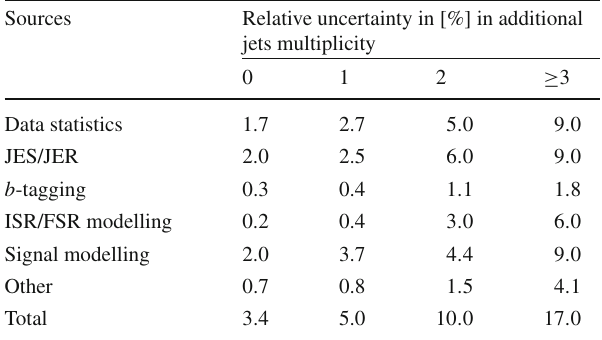
Table3 Summaryofrelativeuncertaintiesin[%]forthejetmultiplicity measurement using a jet p T threshold of 40 GeV. “Signal modelling” sources of systematic uncertainty includes the hadronisation, parton showerandNLOmodellinguncertainties.“Other”sourcesofsystematic uncertainty refer to lepton and jet selection efficiencies, background